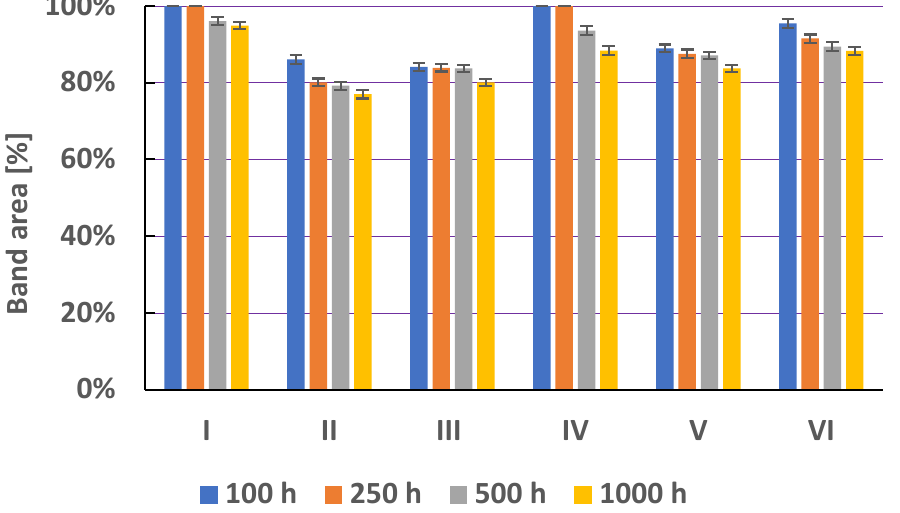
Figure 10. The comparison of means area ( ± SD) (in %) of chromatographic bands obtained from ornidazole (O) in different solvents (I—in water at pH = 2.62; II—in water at pH = 5.56; III—in water at pH = 8.21; IV—in hydrogen peroxide (3%); V—in physiological salt (0.9% NaCl); and VI—in methanol) which were heated at 40 ◦ C during 100, 250, 500, and 1000 h, where SD is the standard devia- tion.